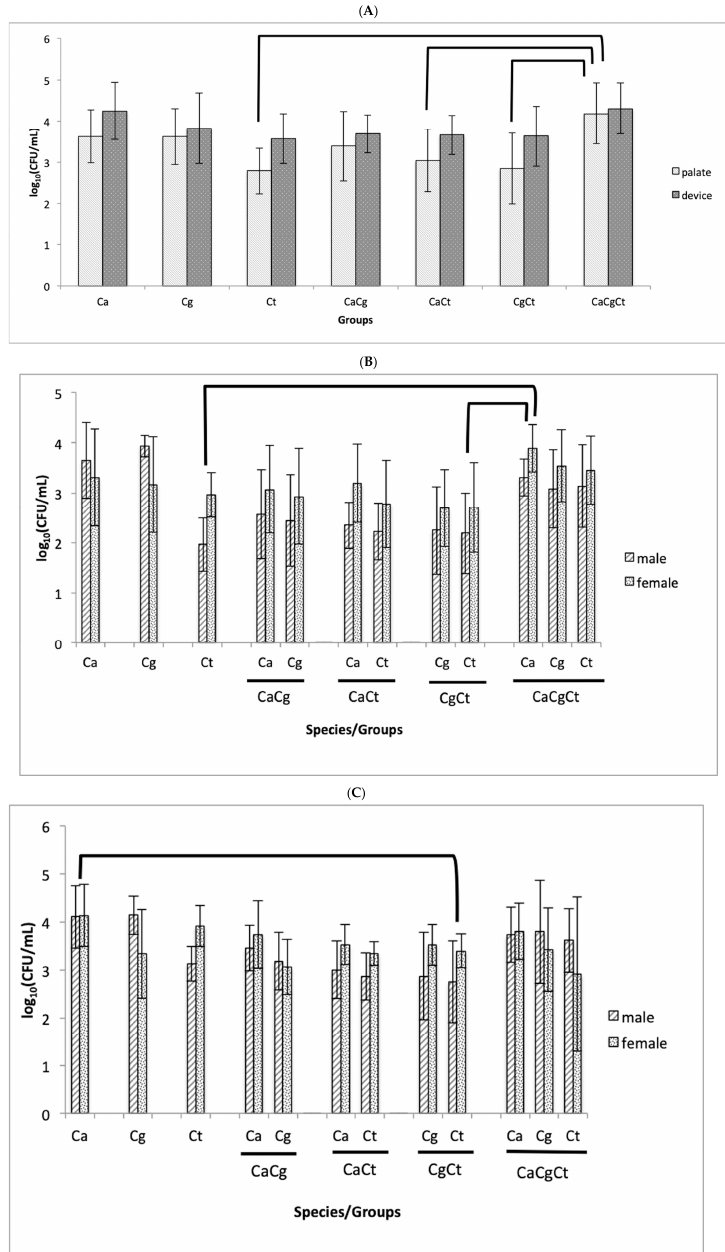
Figure 2. Mean values of log 10 (CFU/mL) of fungi from SDA ( A ) and Candida spp. from CHROMAgar Candida recovered from the palate ( B ) and the device ( C ) after 4 weeks. Error bars: standard deviation ( n = 10 for ( A ), male and female, and n = 5 for ( B , C )); brackets show significant difference ( p < 0.05) among the groups (only for palate in A e for both sexes in ( B , C ). Ca: Candida albicans , Cg: Candida glabrata , Ct: Candida tropicalis , CaCg: C. albicans + C. glabrata , CaCt: C. albicans + C. tropicalis , CgCt: C. glabrata + C. tropicalis , and CaCgCt: C. albicans + C. glabrata + C. tropicalis groups. The colonies grown on CHROMAgar Candida were used to presumptively identify the species of Candida recovered from palate and devices. We also quantified each species of Candida based on the color of the colonies and verified a moderate agreement ( p = 0.578, Interclass Correlation Coefficient, ICC) between the counts of SDA and CHRO- MAgar Candida for palate and an excellent agreement ( p = 0.960, ICC) for the device [43]. Additionally, the Bland–Altman plot showed agreement ( p = 0.149) between the CFU/mL values of SDA and CHROMAgar Candida for palate, despite a proportional bias ( p < 0.001) in the difference values (Figure S2A). For the CFU/mL recovered from dentures, although the t-test showed no agreement ( p = 0.049) between SDA and CHROMAgar Candida and a proportional bias ( p = 0.002) was verified, the Bland–Altman plot (Figure S2B) showed a good agreement between the CFU/mL values, with only some samples above and below the limits of agreement, suggesting absence of systematic discrepancy between the counts from both culture mediums. Therefore, the log 10 (CFU/mL) values from CHROMAgar Candida were submitted to statistical inference. Two-way MANOVA did not show significant interaction ( p = 0.375) between group and sex for the log 10 (CFU/mL) values from both palate and device, but significant effects were observed for gender ( p = 0.025) and group ( p = 0.001). The growth of Candida spp. from female rats was significantly higher ( p = 0.007) than that from male rats for colonies recovered from the palate, while no significant difference ( p = 0.340) between female and male rats was